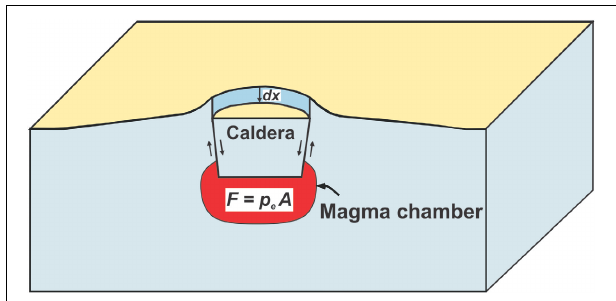
FIGURE 6 | Caldera subsidence largely maintains the excess pressure p e in the magma chamber during a caldera-forming eruption. The excess magma pressure p e in the chamber is equal to the average force F on the cross-sectional area A of the caldera. To reduce the volume of the chamber (to shrink or contract the chamber), the piston-like caldera roof has to move the differential distance dx. These considerations allow us to derive the general relation between the elastic energy associated with magma-chamber volume reduction or shrinkage [Equation (21)] and the elastic energy in terms of eruptive volume and excess magmatic pressure [Equation